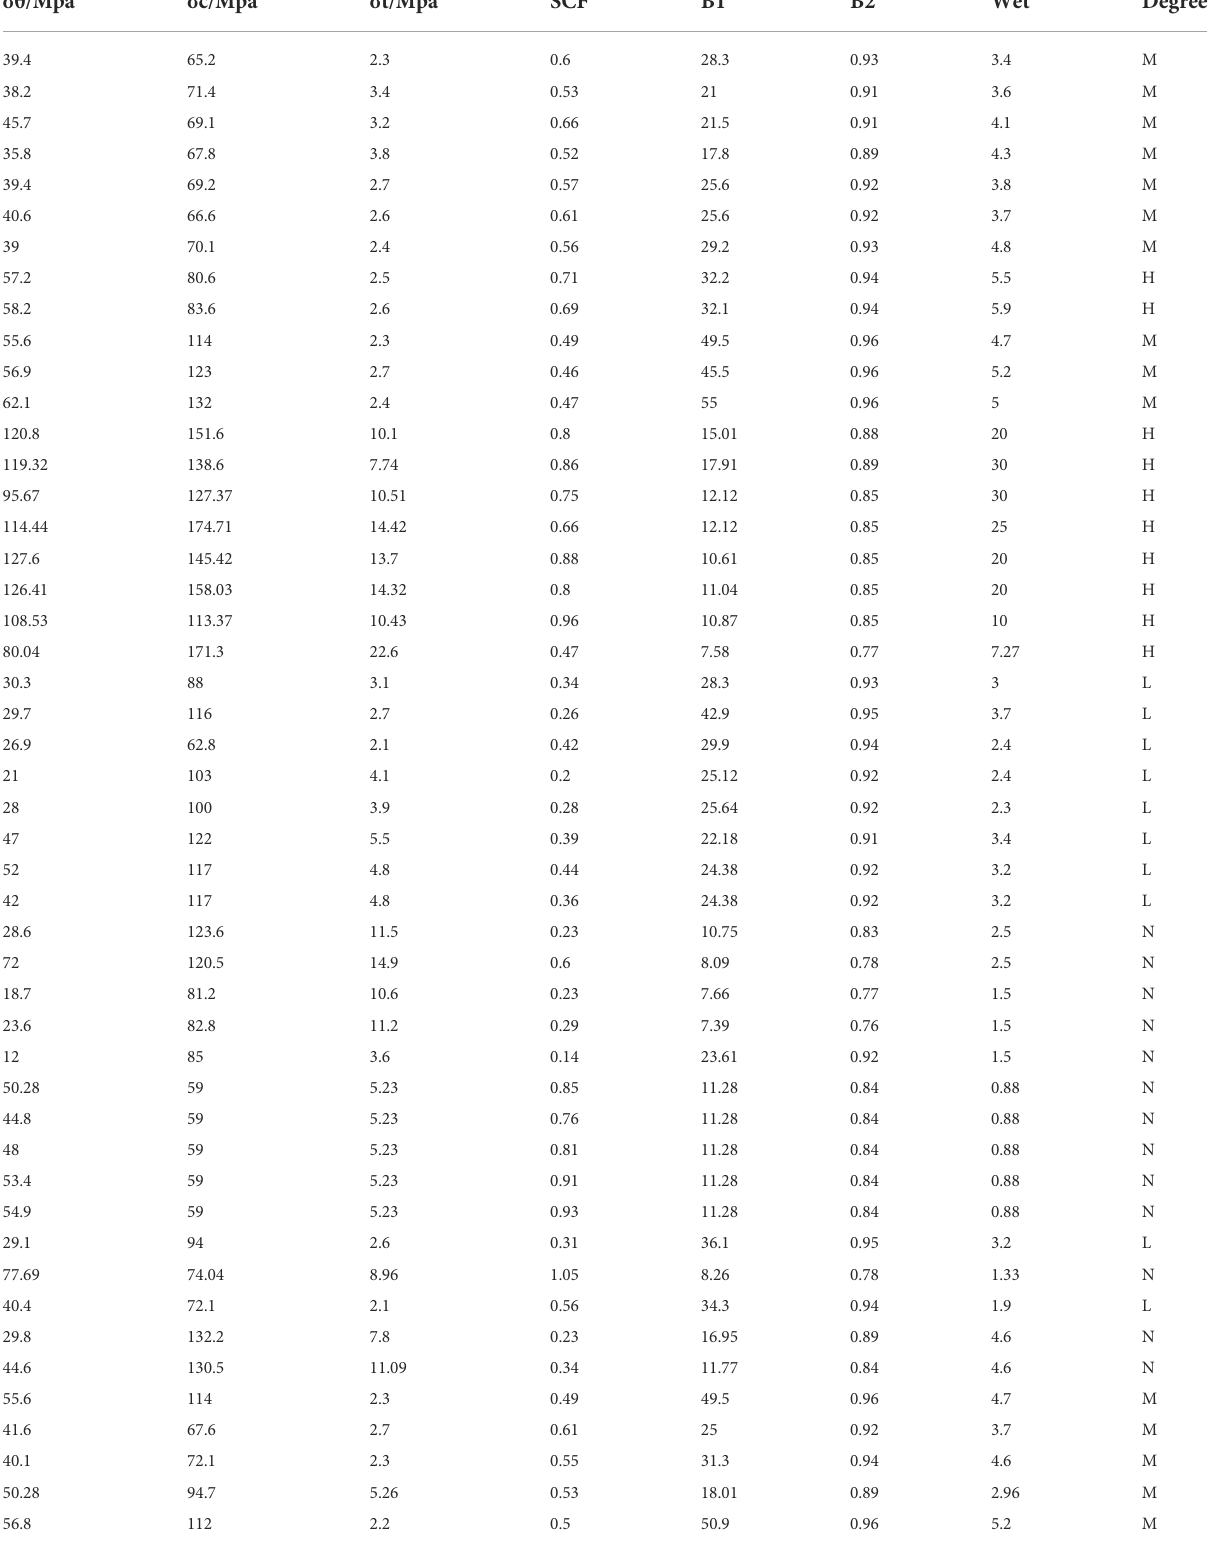
TABLE 3 Set of training samples used in this